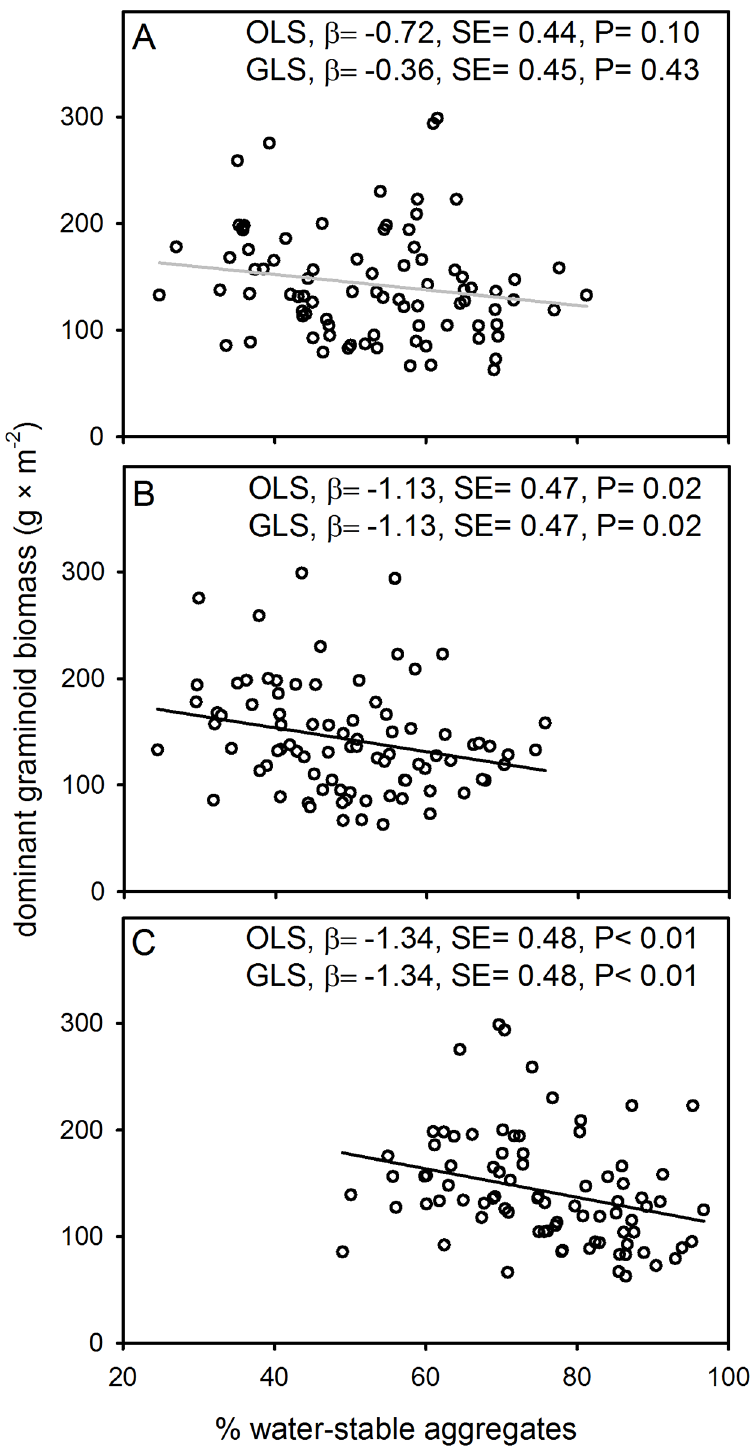
Fig 2. Relationships between % water-stable aggregates and peak annual dominant graminoid (aboveground) biomass (A-C). Panels represent three size classes of macroaggregates: 2 – 4 mm (A), 1 – 2 mm (B), and 0.25 – 1 mm (C) (0 – 10 cm soil depth). Regression slope coefficients ( β ), standard errors (SE), and p-values are provided for regressions based on ordinary least squares (OLS) and generalized least squares (GLS). GLS controls for spatial autocorrelation. Best-fit lines (based on OLS) are black when GLS regressions were significant (P (cid:5) 0.05) or gray when nonsignificant (P > 0.05).